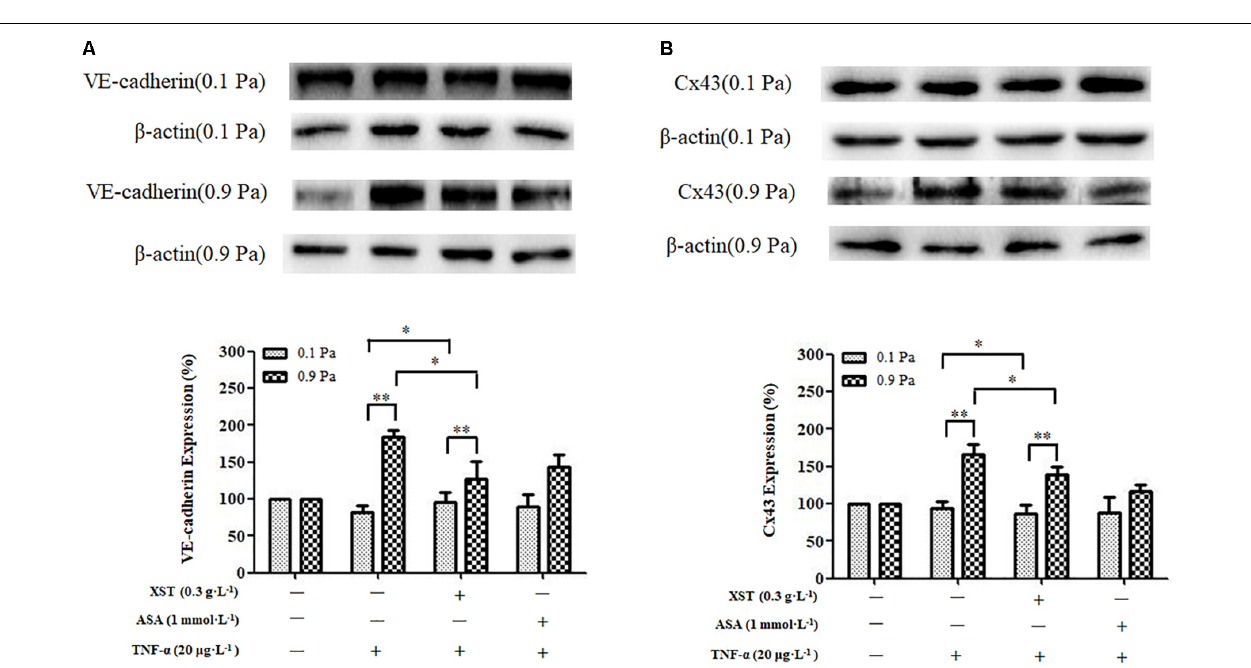
FIGURE 5 | Comparisons of VE-cadherin and Cx43 expression between groups under static condition. (A) The expression and density of VE-cadherin under static condition were analyzed by western blotting. (B) The expression and density of Cx43 under static condition were analyzed. The data was presented as means ± SD, n = 3. ∗ P < 0.05 vs. model.